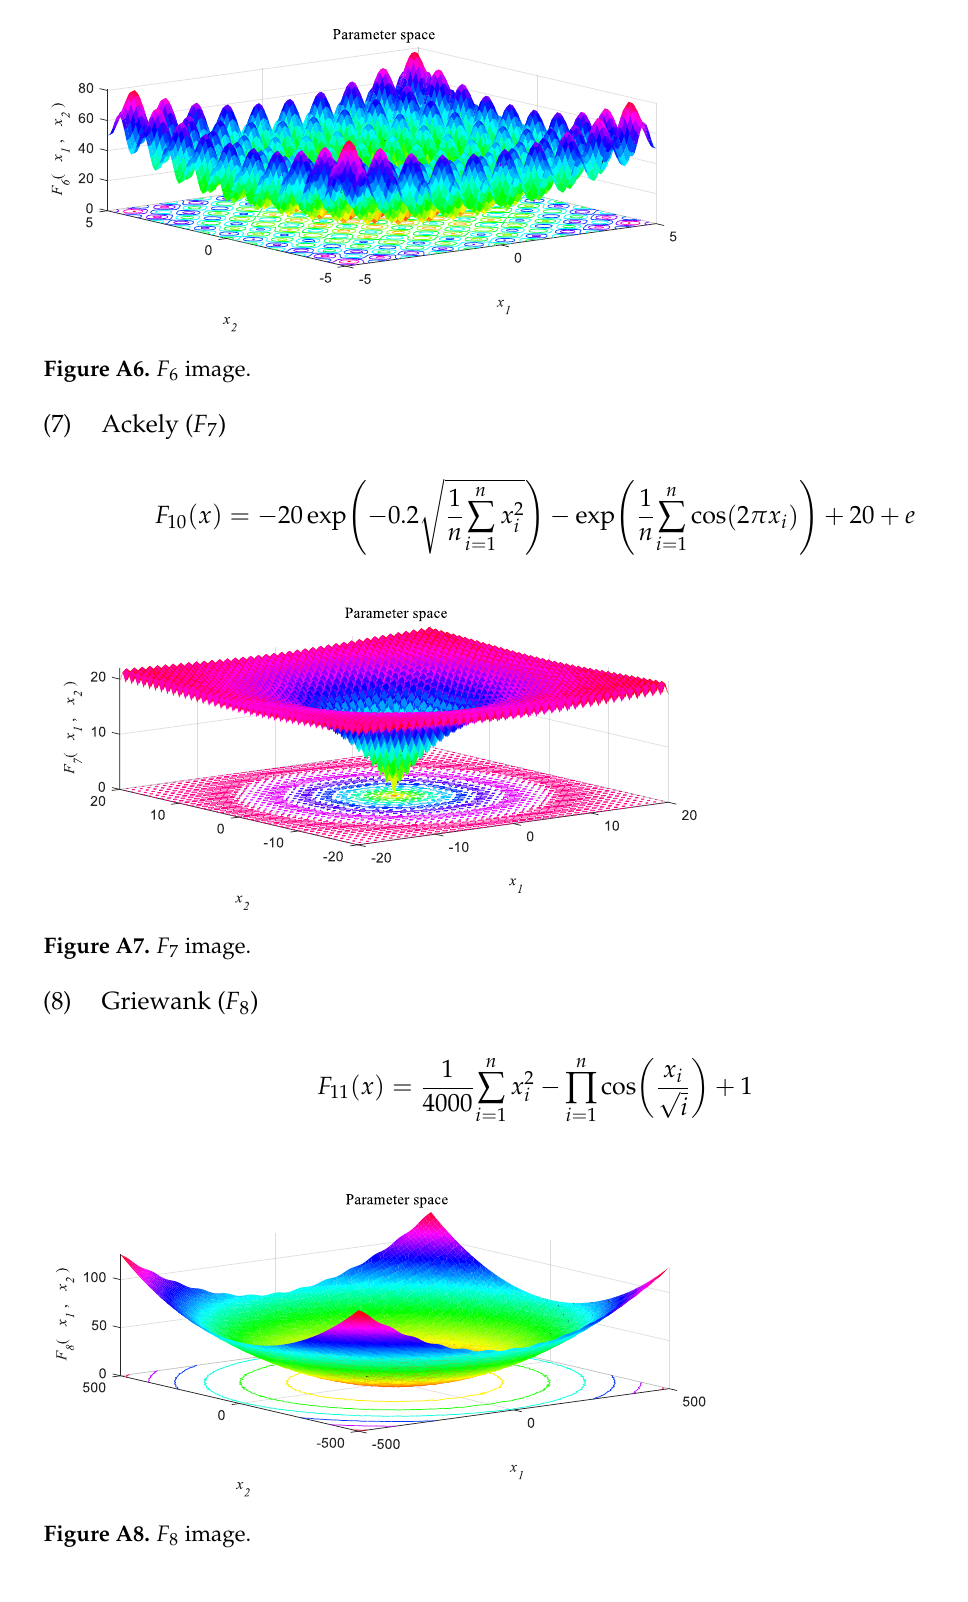
Figure A8. F 8 image.